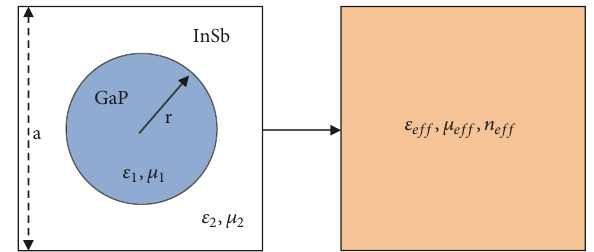
Figure 1: A schematic of a dielectric sphere is embedded into the semiconductor host. r is the radius of the dielectric sphere and 𝑎 is the unit cell